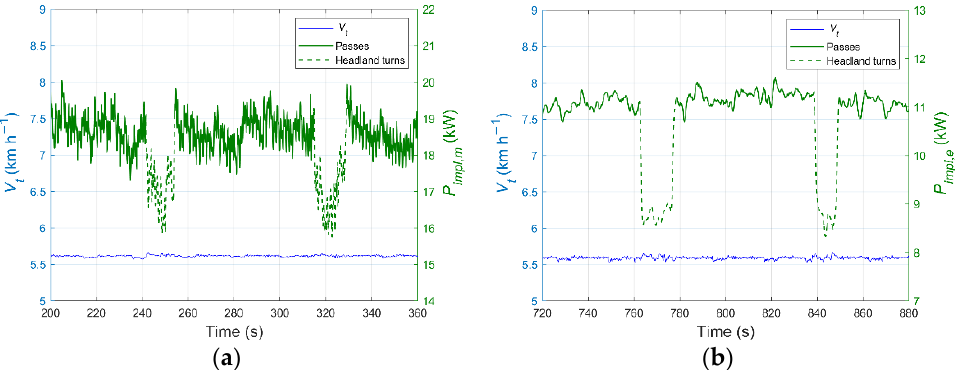
Figure 9. Field with old corn residuals and tall grass to simulate a vineyard interrow (SimVin) during the eMulcher test.